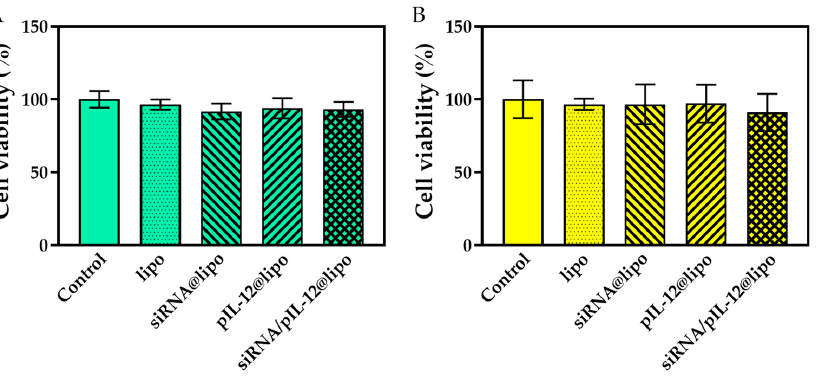
Figure 2. The cell viability of HepG2.215 cells ( A ) and J774A.1 macrophages ( B ) after being